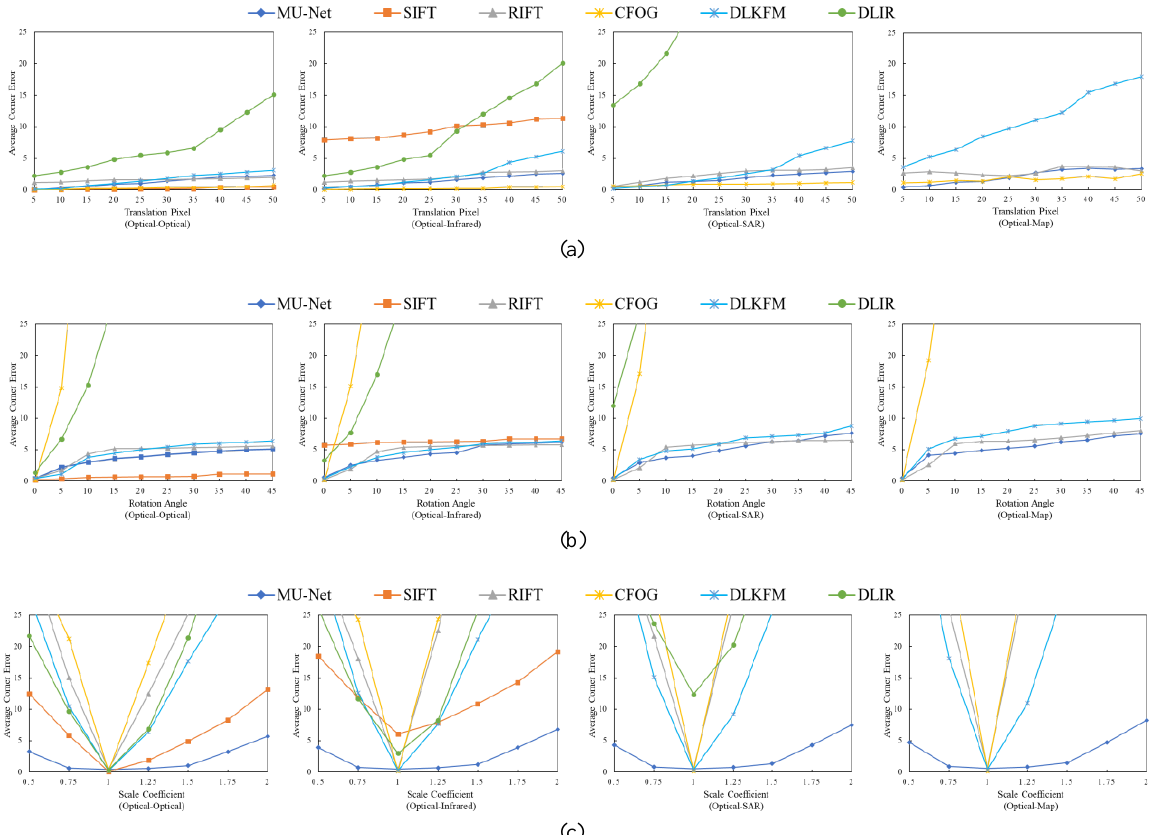
Figure 8. Comparison of ACE on different datasets for (a) translation distortion, (b) rotation distortion, and (c) scale distortion.